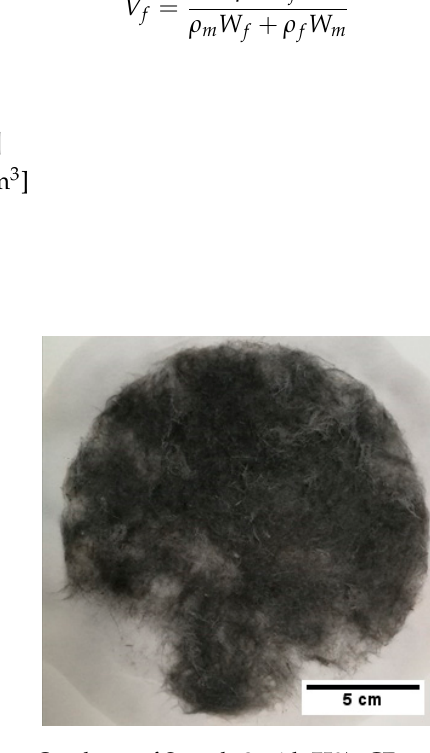
Figure 1. One layer of Sample 2 with 75% rCF and 25% flax.